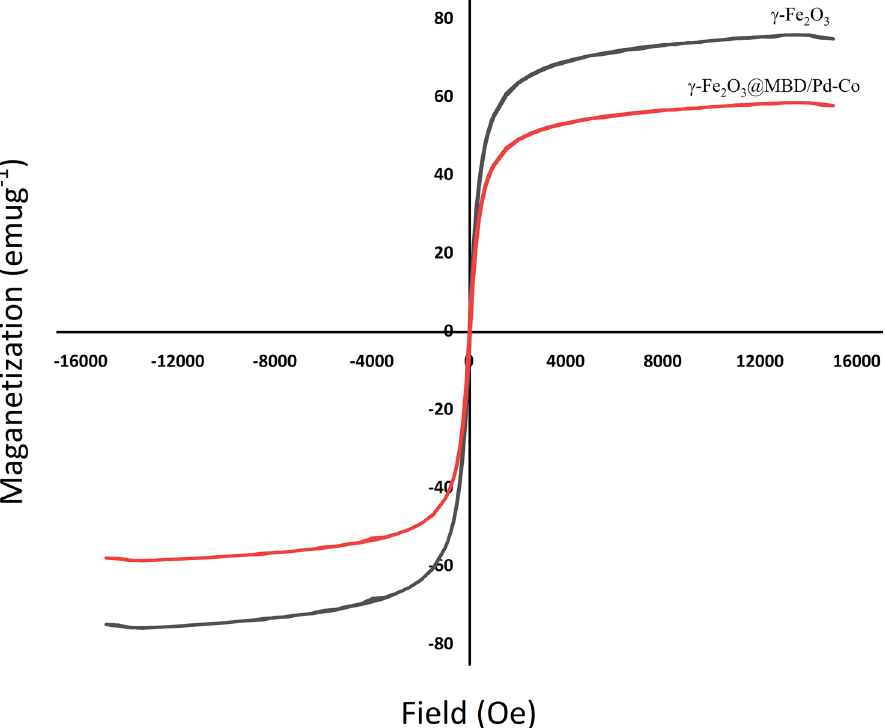
Figure 4. The VSM pattern of γ-Fe 2 O 3 @MBD/Pd-Co and γ-Fe 2 O 3